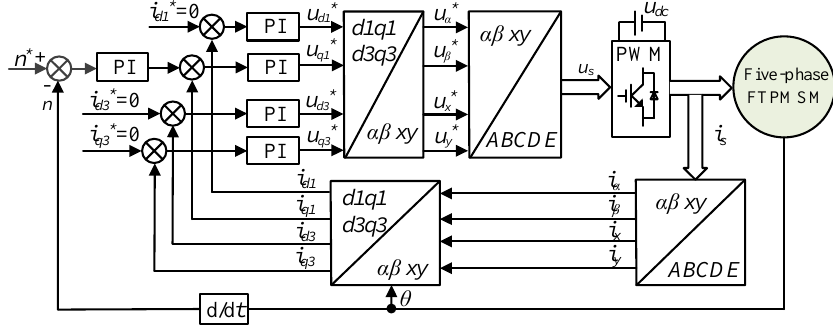
Figure 2. Block diagram of the FOC drive system of the five-phase FTPMSM.